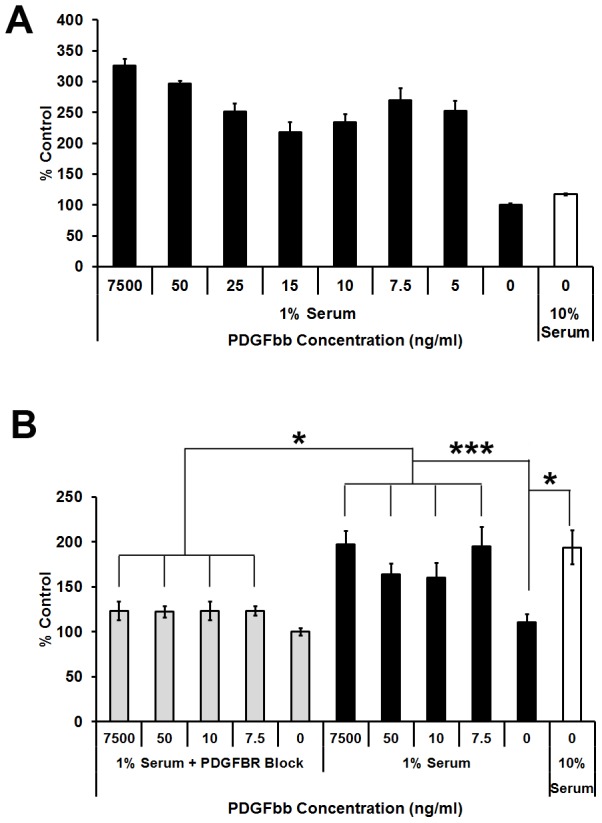
Soluble PDGF-BB promotes proliferation of primary foreskin fibroblasts over 5 days, and can be attenuated by blocking PDGF beta receptors.(A) A trimodal dose dependent response was observed with peak proliferation at 7.5 ng/ml, 7.5 and 50 µg/ml. Results are Mean ± StDev, n = 6. (B) Cell proliferation over 5 days was inhibited for all concentrations of PDGF-BB when PDGF-B receptor in cells were blocked with 10 µg/ml of PDGF beta receptor antibody for 30 min at 37°C prior to cell seeding. Results are Mean ± StDev, n = 6. * P<0.05, *** P<0.001.